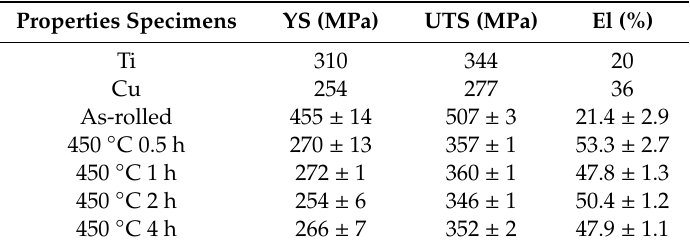
Table2. Tensilepropertiesofbasemetals(TiandCu), as-rolledtitaniumclad, andannealedtitaniumclad. Properties